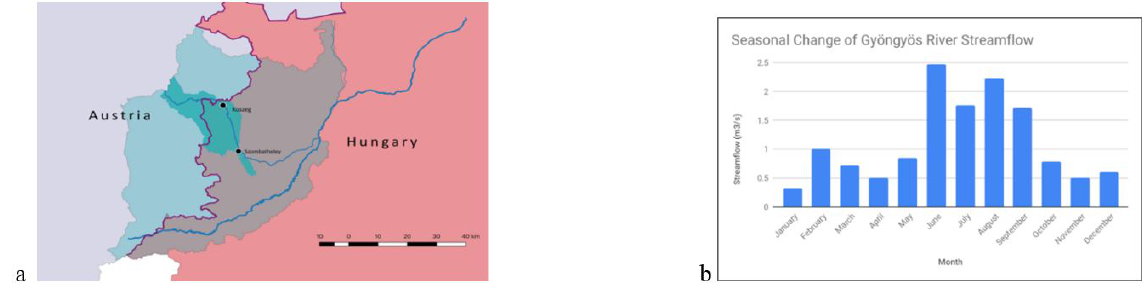
Figure 1. (a).Location and Study Boundary (b)Seasonality in Gy¨ongy¨os River Streamflow Excess